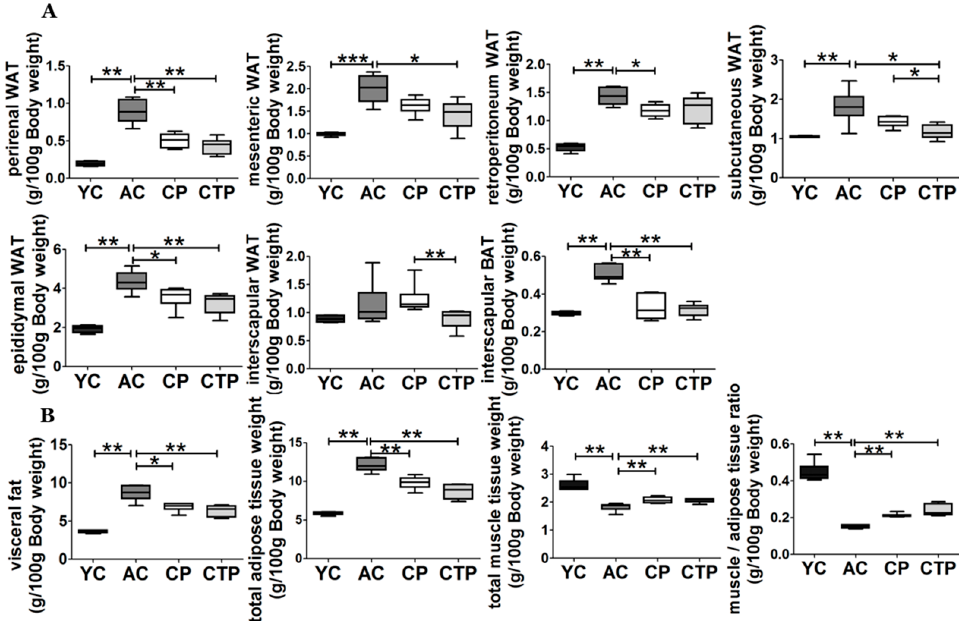
Figure 3. Effect of a 12-week supplementation of CTP and CP on adipose tissue weight (g/100g body weight), muscle/adipose tissue ratio (g/100g body weight), and muscle lipid levels. ( A ) adipose tissue weight (g/100g body weight); ( B ) visceral fat (sum of perirenal WAT, mesenteric WAT, retroperitoneum, and epididymal WAT), total adipose tissue (sum of visceral, subcutaneous and interscapular WAT, and interscapular BAT), total muscle tissue weight (sum of quadriceps, gastrocnemius, tibialis anterior), and muscle/adipose tissue ratio (g/100g body weight). Data are displayed as the mean ± SE. Significant differences are indicated as follows: * p < 0.05, ** p < 0.01, and *** p < 0.001; YC, young mice control (12 weeks old, n = 6); AC, aging control (60 weeks old, n = 6); CP, collagen peptide (60 weeks old, n = 6); CTP, collagen tripeptide (60 weeks old, n = 6).